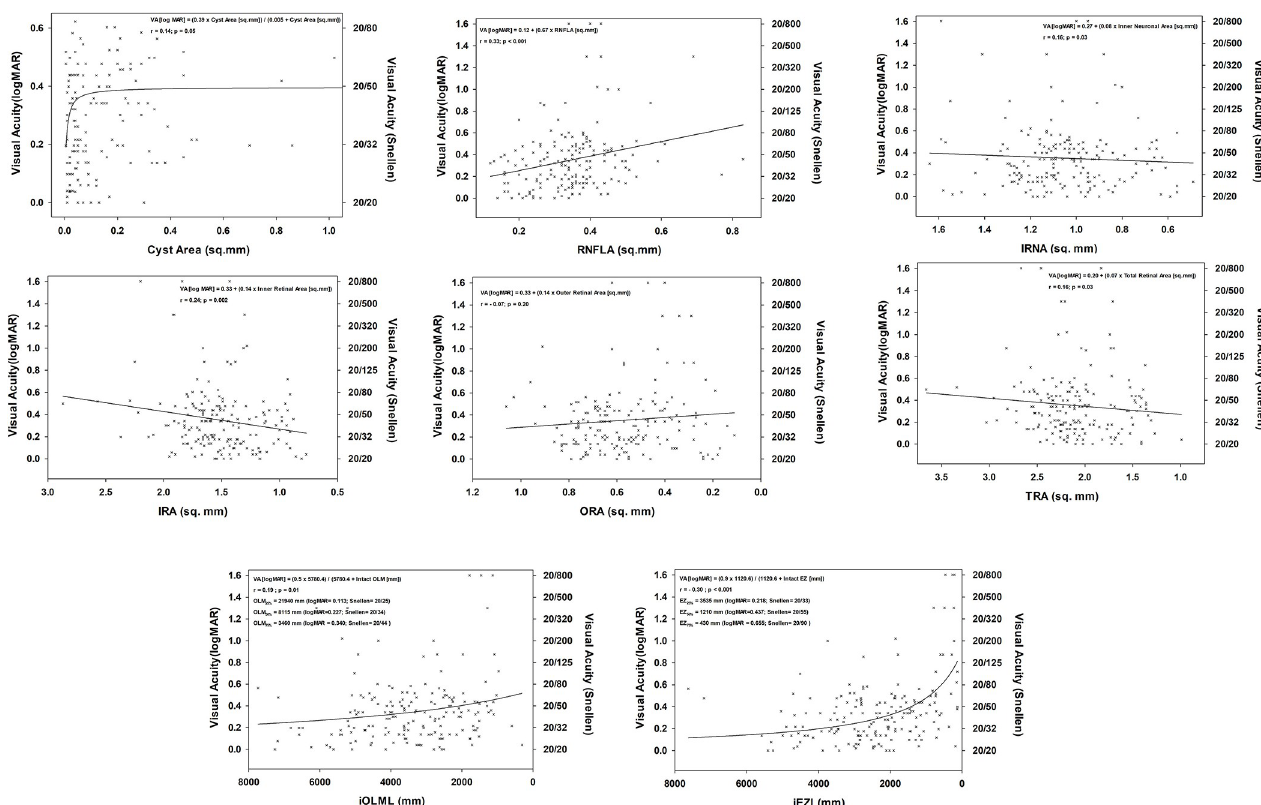
Fig 4. Impact of change in anatomical features on visual acuity. (A) A 2-parameter single rectangular hyperbola best-fits to explain the impact of retinal cysts on visual acuity (r = 0.14, p = 0.05). Cysts cause a 2-line drop in visual acuity early during development. Although cysts may enlarge in time, their impact on visual acuity remains the same. (B) RNFLA has the highest linear correlation with logMAR visual acuity among other studied parameters (r = 0.325, p < 0.001). (c) A weak linear correlation existed between the IRNA and visual acuity (r = 0.160, p = 0.028). (D) An increase in IRA with the development of cysts decreases the patients’ visual acuity (r = 0.238, p = 0.002). (E) No significant correlation was detected between ORA and visual acuity (r = - 0.072, p = 0.197). (F) Similar to the relationship of visual acuity with IRA, the size of cysts affects both the TRA and visual acuity (r = 0.159, p = 0.029). Patients have better visual acuity if the cysts are small; as they get bigger, their visual acuity worsens, and TRA increases. (G) A significant correlation exists between the OLM and visual acuity, which fits-best to a 2-parameter hyperbolic curve in the form f = (a � b)/(b+x) (r = 0.19, p = 0.01). The 50 th percentile of this effect corresponds to 8115 mm of intact OLM and visual acuity of 20/34. (H) iEZL significantly correlates with visual acuity. Distribution of the data best-fits to a 2-parameter hyperbolic curve in the form f = (a � b)/(b+x) (r = 0.30, p < 0.001). The 50 th percentile of this effect corresponds to 1210 mm of intact EZ and visual acuity of 20/55. (r = 0.238, p = 0.002, Fig 4D), TRA (r = 0.159, p = 0.029, Fig 4F), iOLML (r = - 0.193, p = 0.01, Fig 4G), and iEZL (r = - 0.296, p < 0.001, Fig 4H). Multivariate linear regression analyses indi- cated iEZL (B = -5.16E-5; p < 0.001), the inheritance pattern (B = 0.04; p = 0.028), and RNFLA (B = 0.751; p < 0.001) as the main variables that can determine the 20.3% of the visual